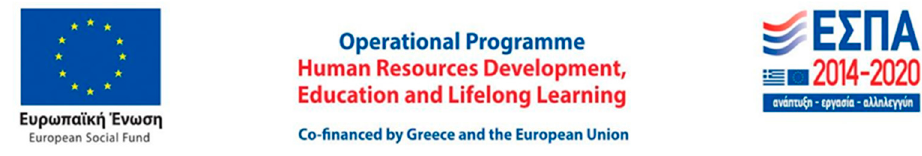
Figure S2. PCA model showing QC samples in blue and control and cocaine-treated intracellular material samples in grey. Figure S3. OPLS-DA model showing control (blue) and cocaine-treated (red) intracellular samples which are discriminated clearly (all control samples in the left side and all the treated in the right side). Figure S4. PCA model showing QC (blue) and control, cocaine-treated cell medium samples (grey). Figure S5. OPLS-DA model showing control (blue) and cocaine-treated (red) cell medium